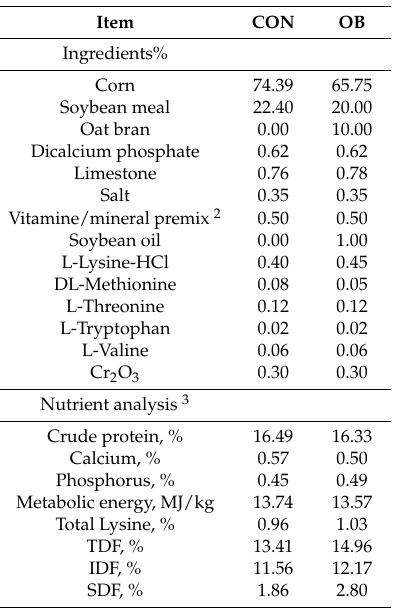
Table 5. Composition and nutrient analysis of experimental diet 1 (as-fed